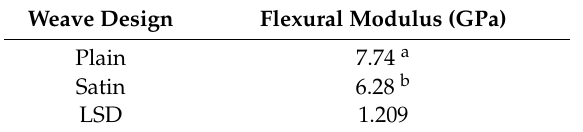
Table 7. Flexural properties of woven kenaf/carbon fibre hybrid composite at different weave design.